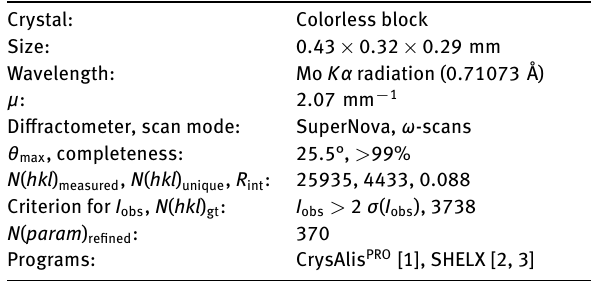
Table 2: Fractional atomic coordinates and isotropic or equivalent isotropic displacement parameters (Å 2